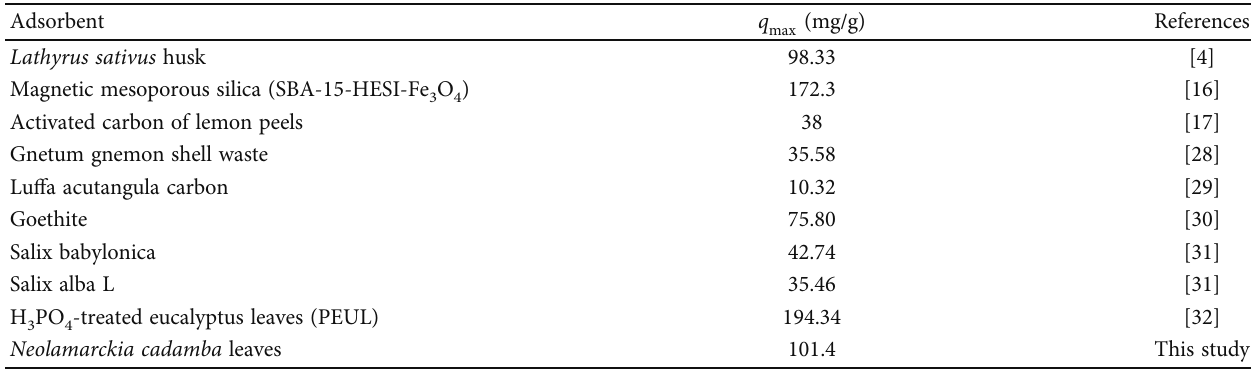
Table 7: Comparative study of adsorption capacity ( q Adsorbent q